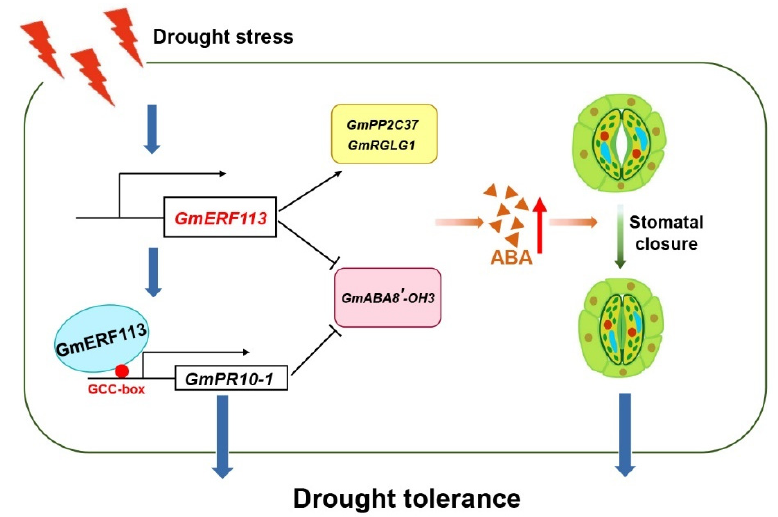
Figure 9. A molecular model of the GmERF113 in the soybean response to drought stress. When soybean plants are subjected to drought stress, GmERF113 is rapidly activated and transcribed, and then GmERF113 activates the expression of PR10-1 by binding to the GCC-box in the PR10-1 promoter, thereby enhancing the drought resistance of soybean plants. In addition, Gm ERF113 promotes the expression of two genes which are in the ABA signaling pathway, GmPP2C37 and GmRGLG1 , also both GmERF113 and GmPR10 decrease the expression of an ABA catabolic gene, GmABA8 ′ -OH 3 , thereby the ABA content in the plants can be increased. The increased ABA level further promotes the closure of stomata and thus improves the drought tolerance of soybean plants.